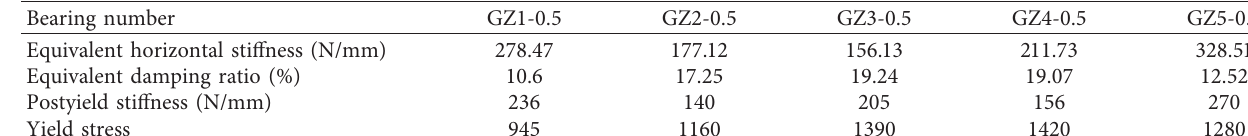
Table 2: LRB horizontal stiffness calculation results.